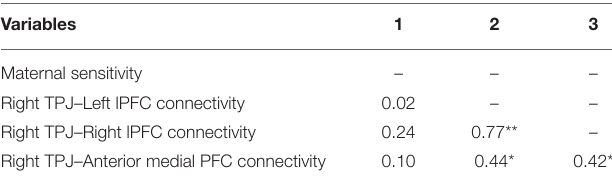
TABLE 3 | Associations among maternal sensitivity and extracted neural connectivity